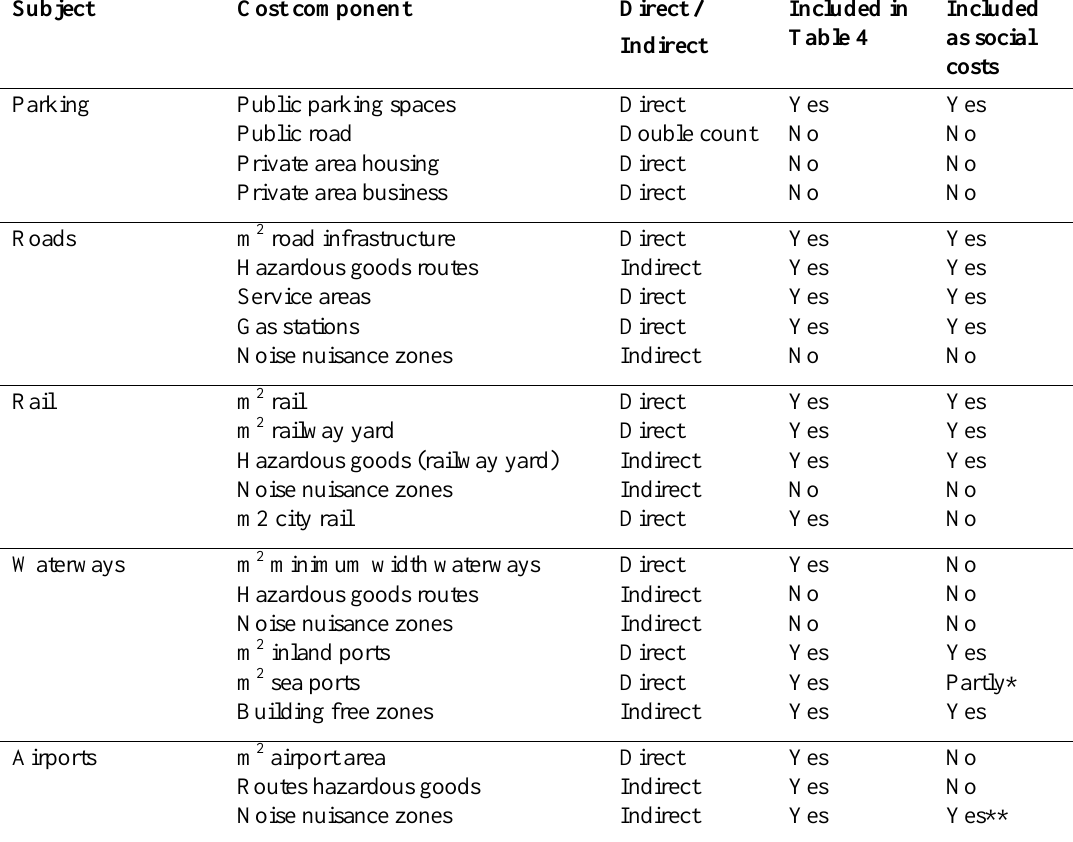
Table 5. Classification of land uses and implications for the social costs of